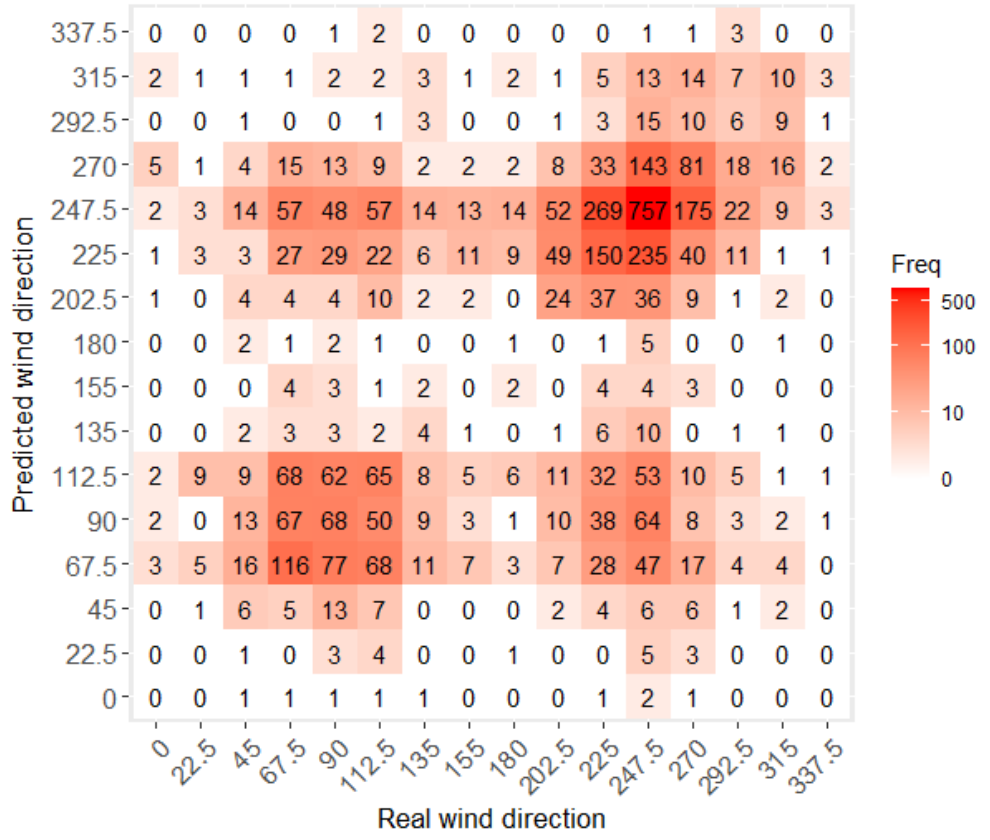
Figure 12. Confusion matrix of the results of the wind direction classification performed on the testing data set using random forest